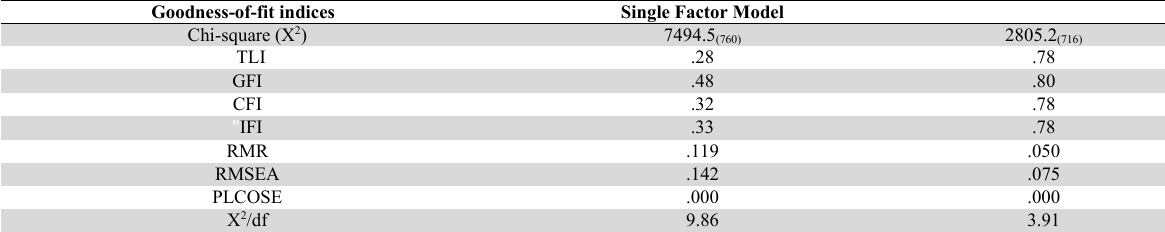
Goodness of Fit Statistics for Measurement Model Goodness-of-fit indices